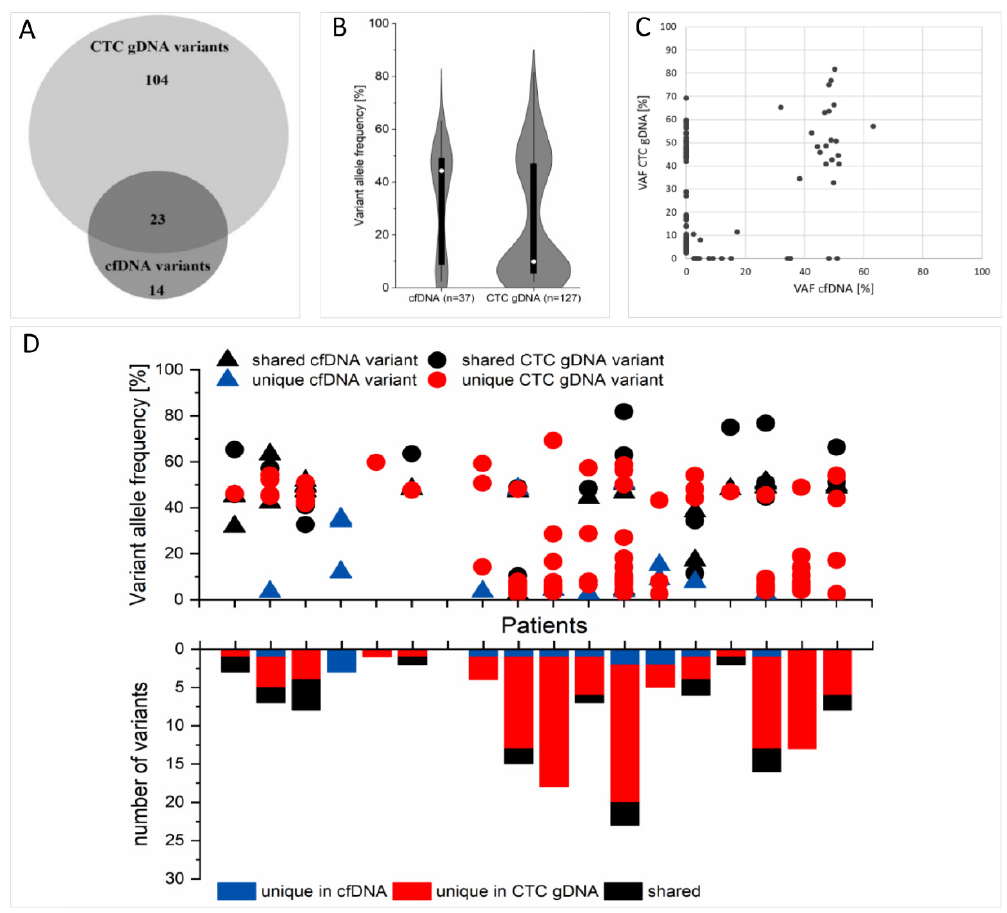
Figure 3. Direct comparison of cfDNA and CTC gDNA variants. ( A ) Venn diagram illustrating the concordance of detected cfDNA and CTC gDNA variants in 18 matched samples. ( B ) Violin diagram showing the distribution of variant allele frequencies of the detected variants in each fraction. The midpoints indicate the median, the black boxes indicate data from the first to the third quartile, the whiskers indicate the area within 1.5 of the interquartile range and the violins extend to the full range of data. ( C ) Variant allele frequencies (VAFs) of the unique and shared variants are plotted. ( D ) Top: VAFs of variants separated by patient and fraction. Bottom: number of variants separated by patients and fractions. Colors indicate whether the variants were found in cfDNA only (blue), CTC gDNA only (red) or whether the same variant was found in both cfDNA and CTC gDNA